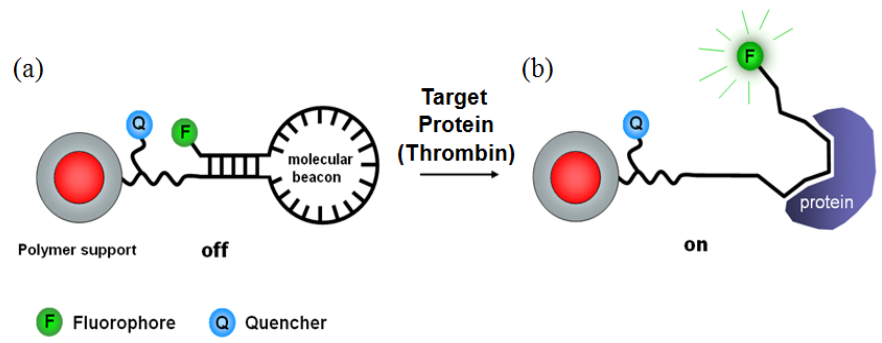
Figure 4. Schematic illustration of MBs on optically-encoded beads for detecting thrombin without additional labeling. ( a ) before thrombin addition; ( b ) after thrombin addition